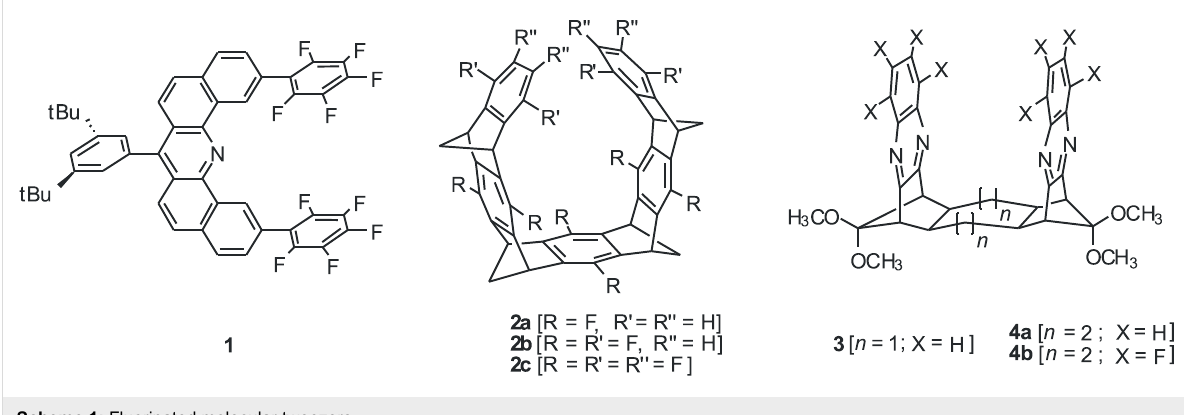
Scheme 1: Fluorinated molecular